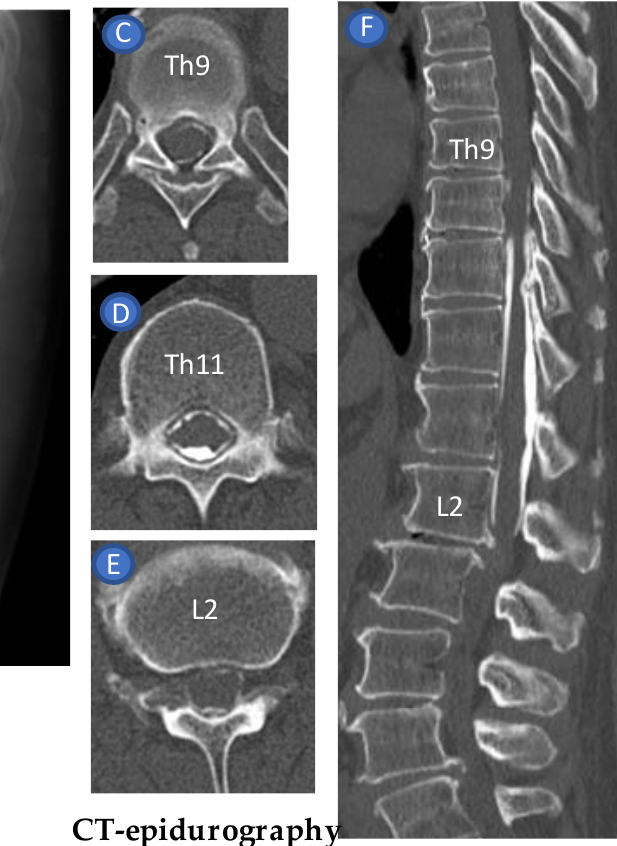
Figure 10. Epidurography and CT epidurography after US-guided epidural injection at L1/2 administered to a 63-year-old male with severe pain in his right buttock extending to the posterior lower leg associated with lumbar canal stenosis (case 1). Anteroposterior ( A ) and lateral view ( B ) of epidurogram revealed compression of the dural sac with incomplete epidural contrast spread on the caudal border of L2. The anterior and posterior epidural space could be identified on the transverse views at the Th9 ( C ), Th11 ( D ) and L1 ( E ) levels by CT epidurography. The axial CT epidurogram ( F ) confirmed the spread of the contrast from L2 to Th9.